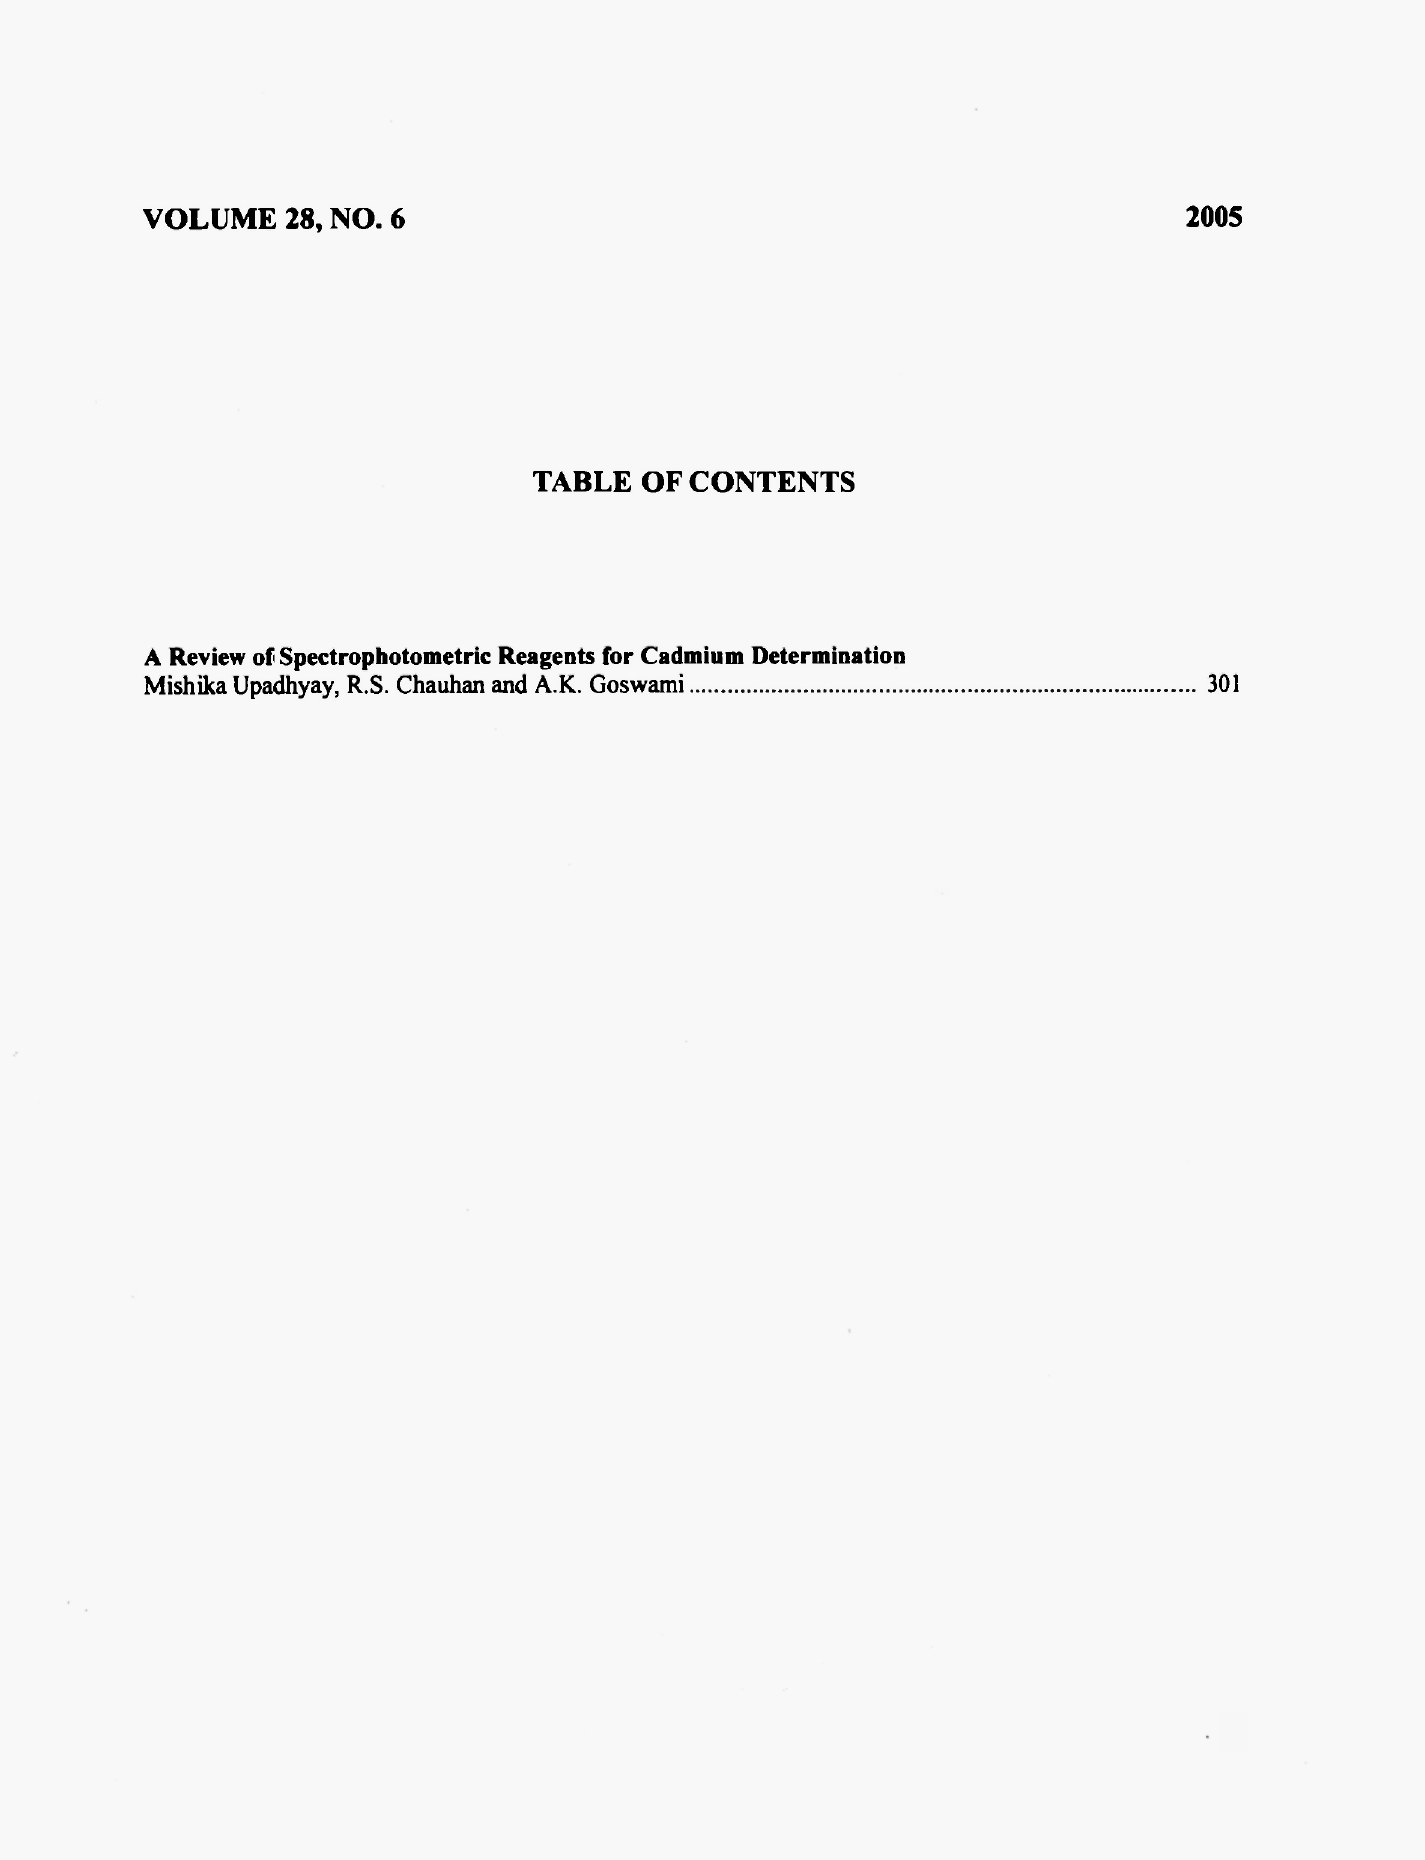
Α Review of Spectrophotometric Reagents for Cadmium